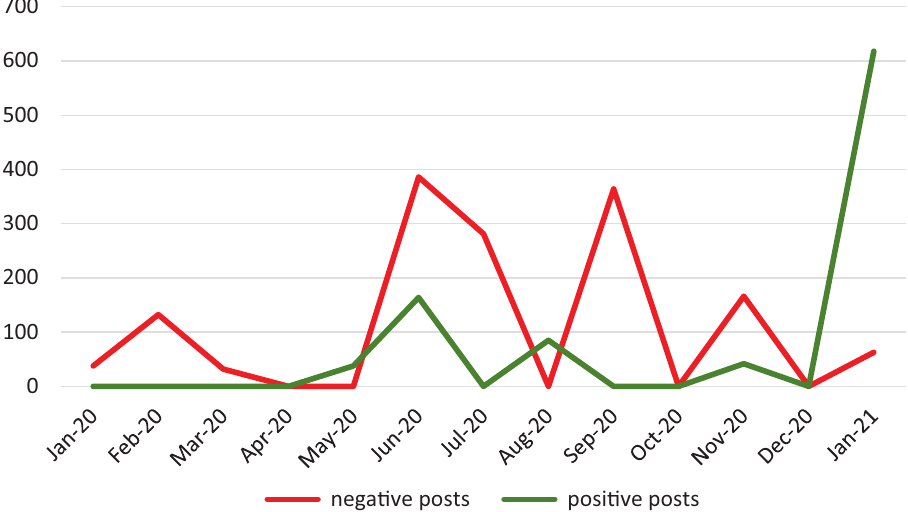
Figure 10. Timeline of reactions on design